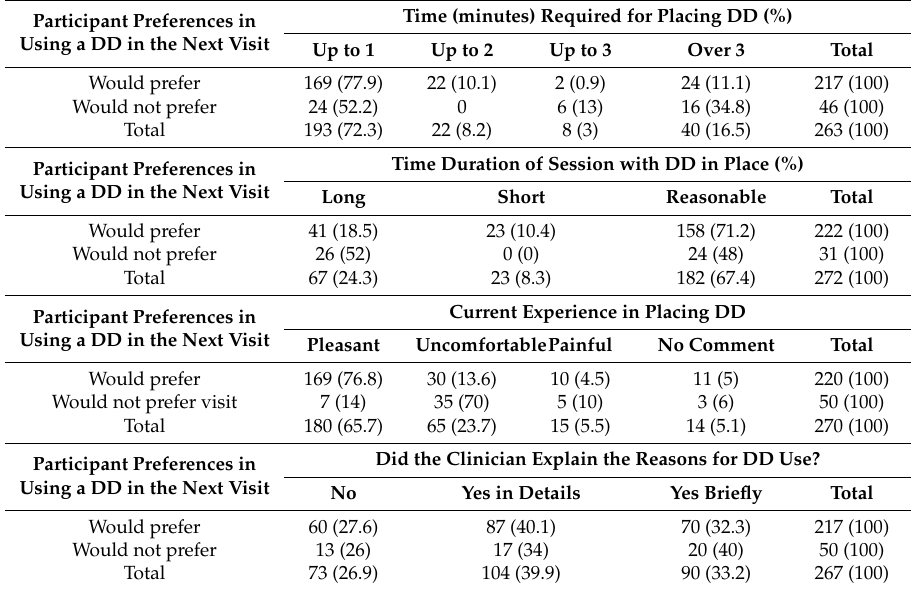
Table 5. The correlation between participant preferences in using a DD in the next visit and factors related to the current treatment session (time to place DD, duration of the current session, personal experience of the current session and dentist explanation to participants on reasons for DD